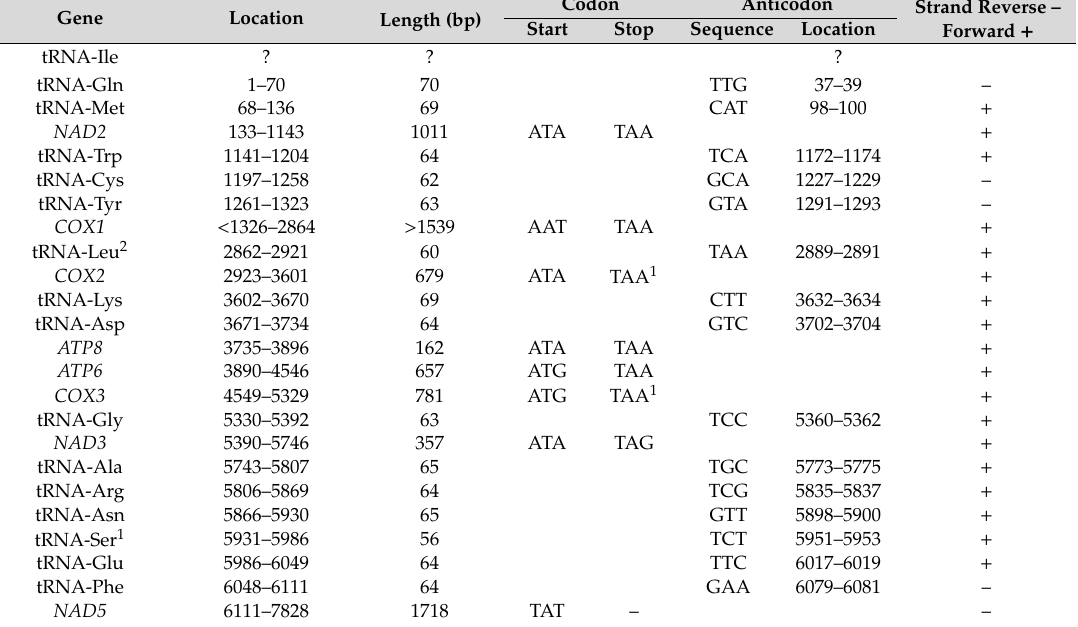
Table 2. Summary of Eriopis patagonia mitogenome annotation. The exponent numerals in gene column are used to di ff erentiate each of the two Leucine- and Serine-specifying transfer RNAs (tRNAs) (Leu 1 and Leu 2 , Ser 1 and Ser 2 ); TAA 1 stop codon is completed by the addition of 3 (cid:48) A residues to mRNA; (–) stop codon not